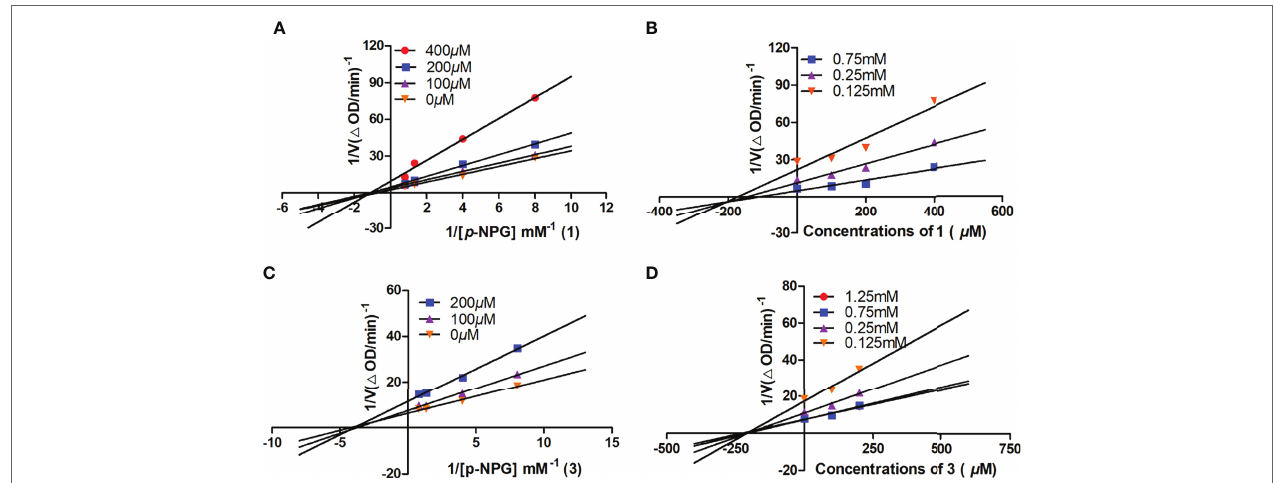
FIGURE 7 | The Lineweaver–Burk and Dixon plots for α -glucosidase inhibition of compounds 1 (A, B) and 3 (C, D)